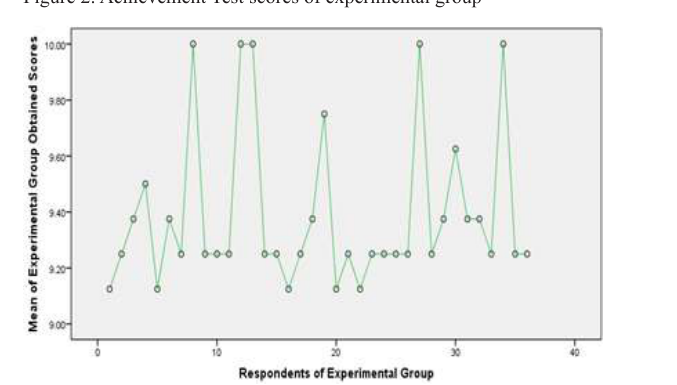
Figure 2. Achievement Test scores of experimental